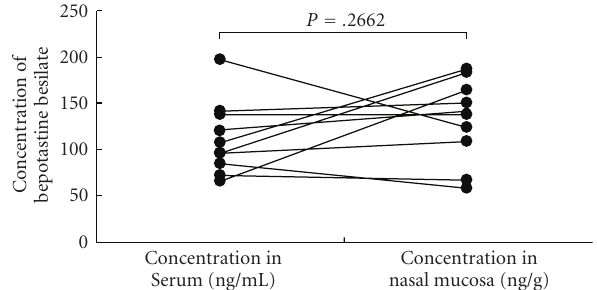
Figure 2: The graphs demonstrated the result of the concentration of bepotastine besilate in the serum and nasal mucosa of chronic rhinosinusitis without allergic rhinitis and compares using a paired t -test.